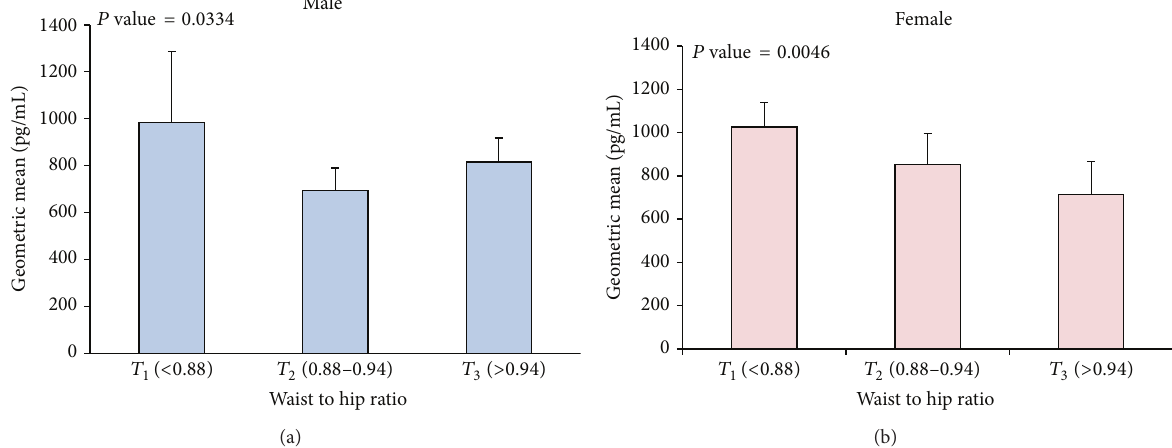
Figure 4: Age and BMI adjusted geometric means of ghrelin level and their effect on waist to hip ratio. (a) Age and BMI adjusted ghrelin levels according to tertiles of waist to hip ratios ( 𝑇 1 < 0.88, 0.88 ≤ 𝑇 2 ≤ 0.94, and 𝑇 3 > 0.94) showing association between increasing waist to hip ratio and decreasing ghrelin level in males ( 𝑃 -trend = 0.0334). (b) Age and BMI adjusted ghrelin levels according to tertiles of waist to hip ratios showing significant reduction in ghrelin level in subjects with higher waist to hip ratios in females ( 𝑃 -trend =